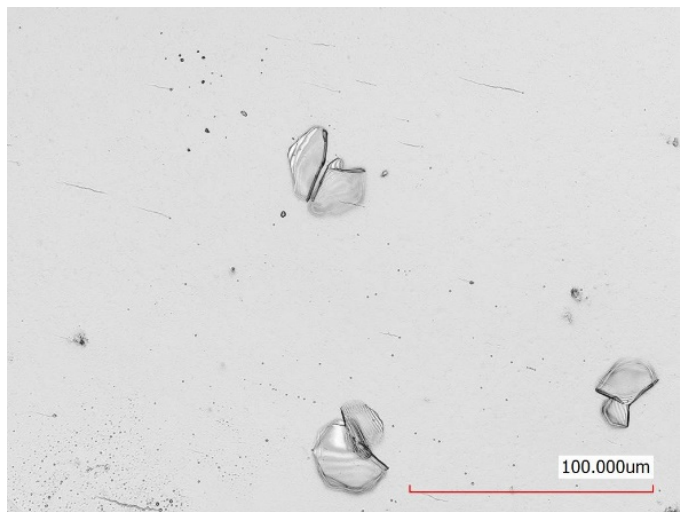
Figure 7. Surface of the 0.3-mm sample. W–Zr–B film after LASAT with laser pulse energy of 1 J and duration of 10 ns. Delaminated fragments of the W–Zr–B film are clearly visible. In the case of the 0.3-mm thick plate, delamination of the coatings can be visible (Figure 8). The maximum delamination height (determined in a reference to non-deformed film) was 1.6 to 2.5 um and the diameter was about 0.2 mm. No protuberance was observed when a laser pulse energy of 0.7 and 0.5 J was used. Adhesion can be estimated based on value of the maximum amplitude of compressive shock wave at the interface. Delamination is caused by tensile shock wave emerging due to reflection of compressive wave from the free surface. In case of the W–Zr–B film ( ρ = 10.95 g/cm 3 , c = 6600 m/s [40,52]) on steel substrate the ratio of acoustic impedances is about 0.64. Relative amplitude of the wave transmitted from steel to the film is T = 0.78. In the case of 0.3-mm thick steel, the amplitude of pressure wave on steel/film boundary is about 700 MPa. The estimated amplitude of the tensile wave that caused coating delamination was about 320